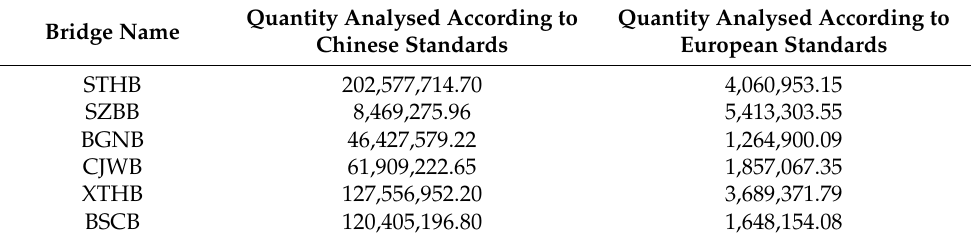
Table 7. Environmental pollution data in Europe and China during the maintenance phase. Unit: